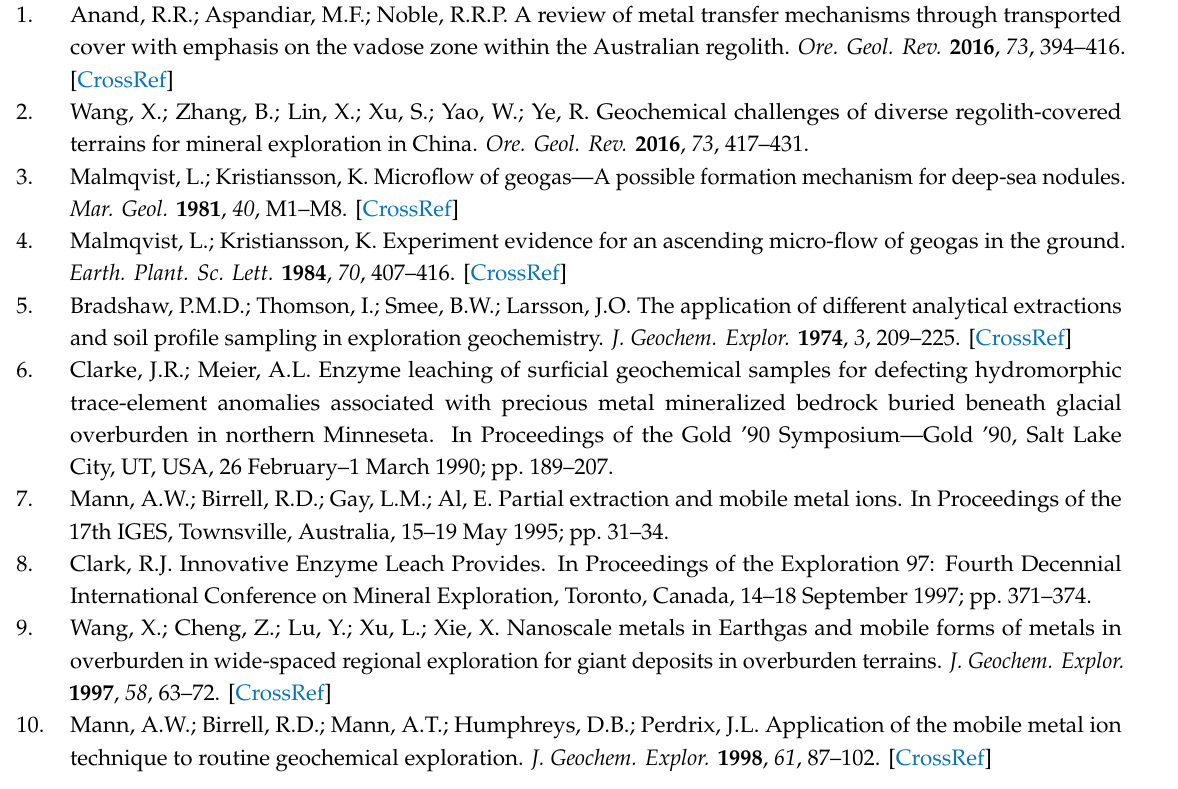
Author Contributions: X.W. and B.Z. conceived and designed the experiments; H.L. and H.W. collected the samples, Z.H. and H.F. performed the TEM experiments, B.Z. and Z.H. analyzed and wrote the paper, Z.H.